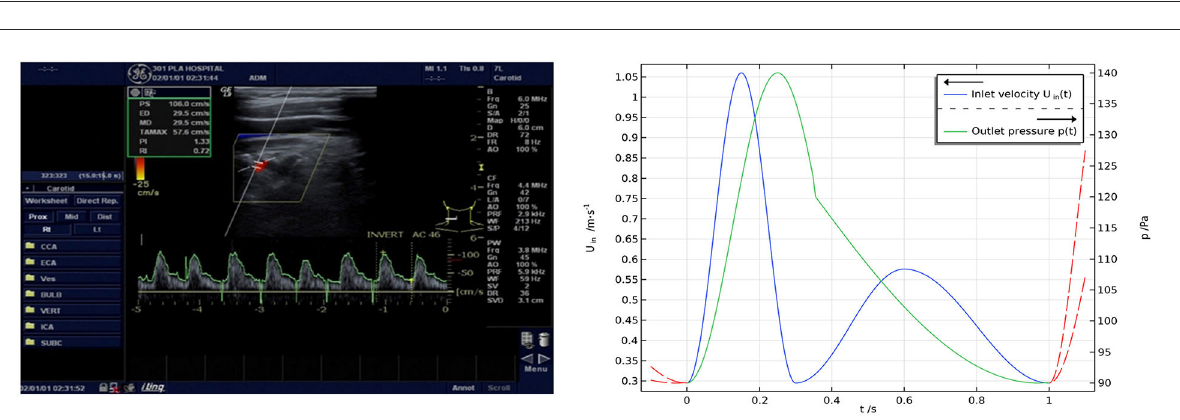
FIGURE3 (Left) Results of Doppler ultrasonic velocimetry and (right) boundary conditions. The inlet boundary condition was set to a velocity condition measured with Doppler ultrasound, and the outlet boundary condition was set to a pressure condition according to clinical